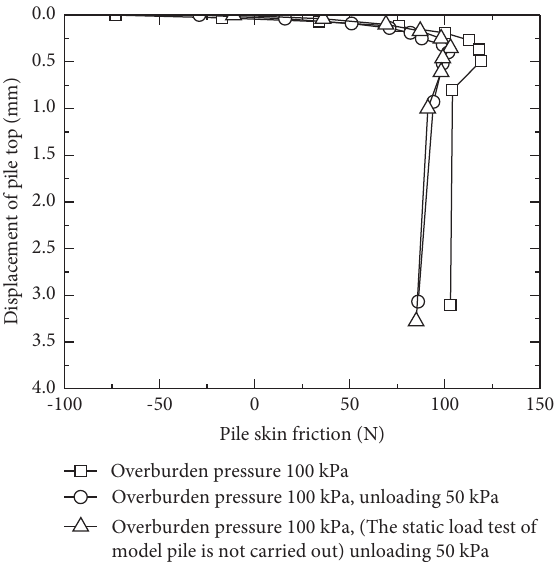
Figure 18: Pile skin friction versus pile top displacement.